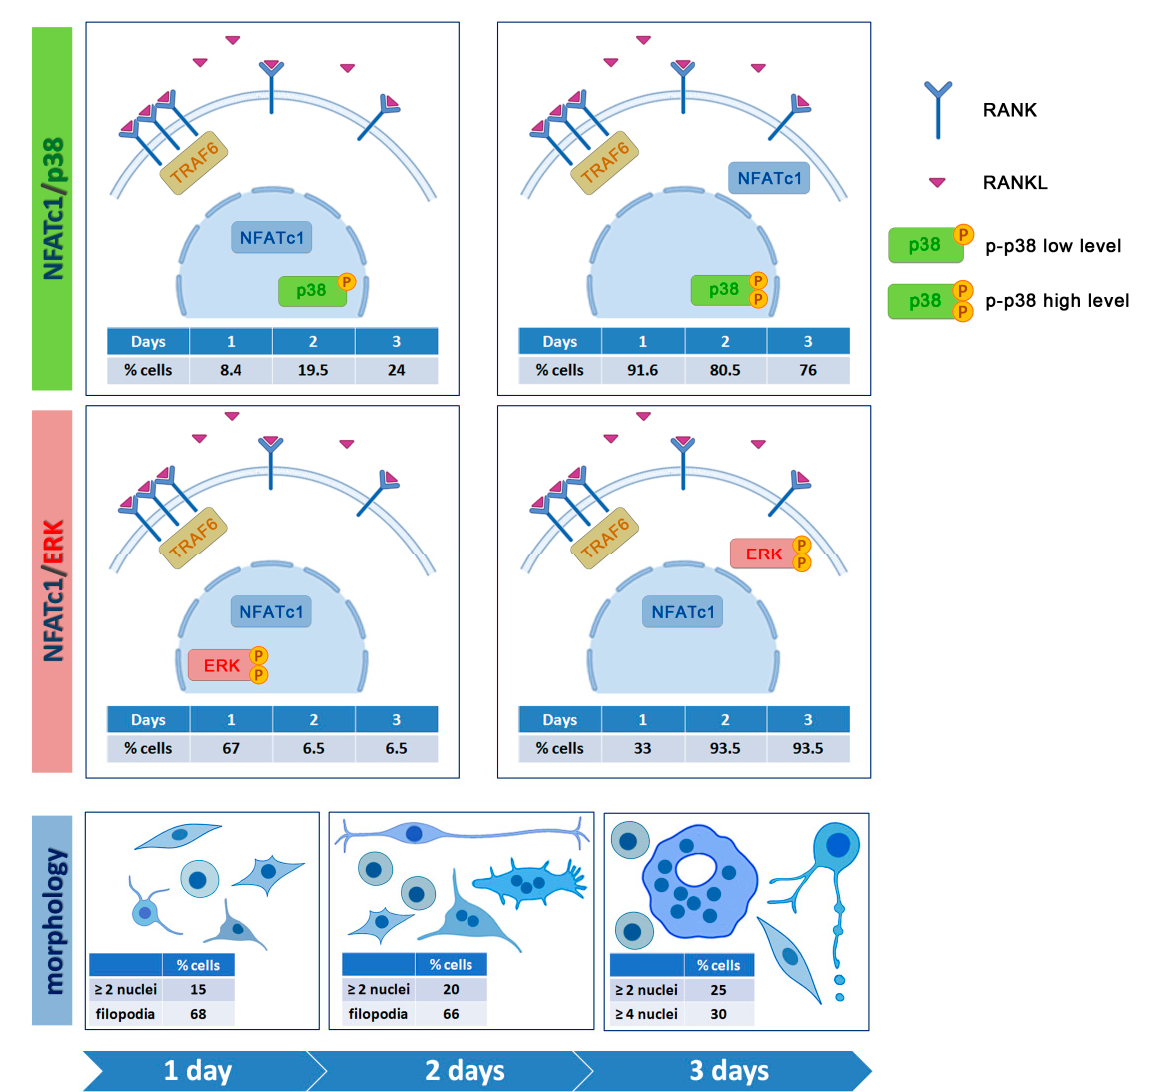
Figure 10. Schematic view of NFATc1, p-p38, p-ERK relationships, and morphologies during OC differentiation. In the upper panels, NFATc1/p-p38 sub-cellular co-localization and the percent of cells (shown in the tables within the panels) at 1, 2, and 3 days are represented. In the intermediate panels, NFATc1/ERK sub-cellular co-localization and the percent of cells (shown in the tables within the panels) at 1, 2, and 3 days are represented. In the lower panels, the various morphologies observed in cell populations at 1, 2, and 3 days are represented.